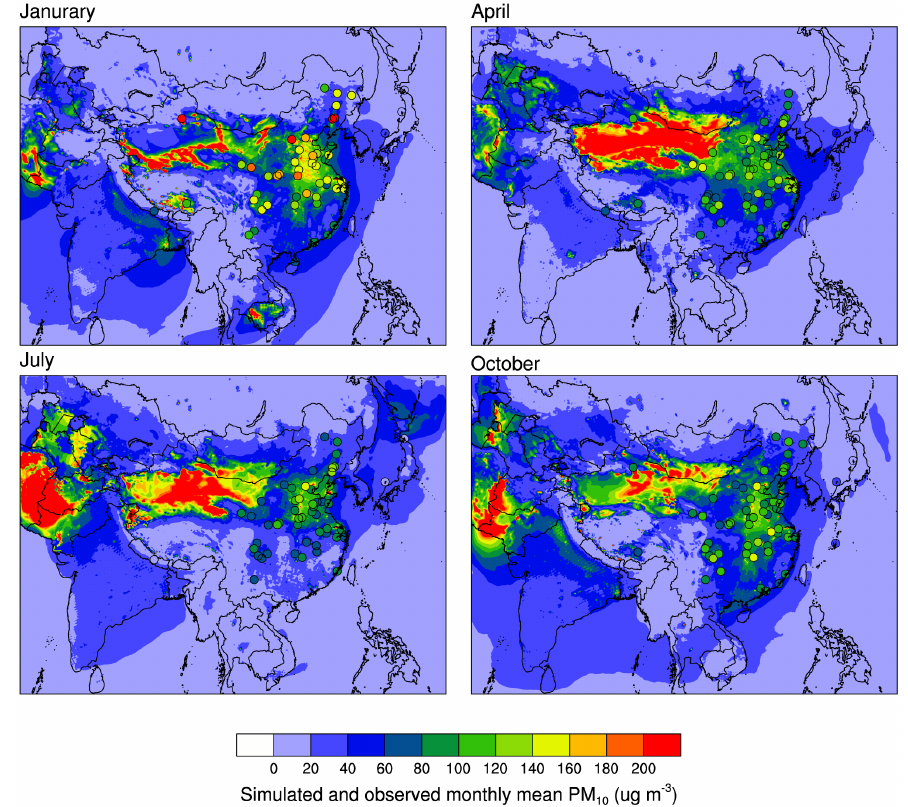
Figure 4. Simulated and observed monthly average surface PM 10 in 2007 using WRF-Chem–REAS. The filled circles indicate the observed monthly average